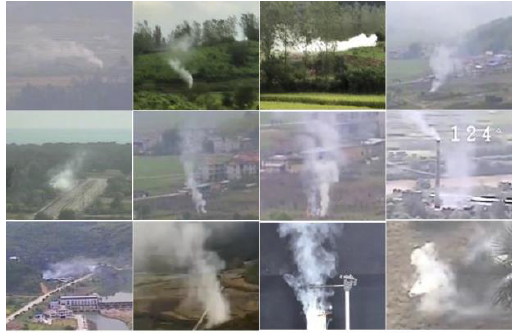
Algorithm 1. The proposed algorithm.